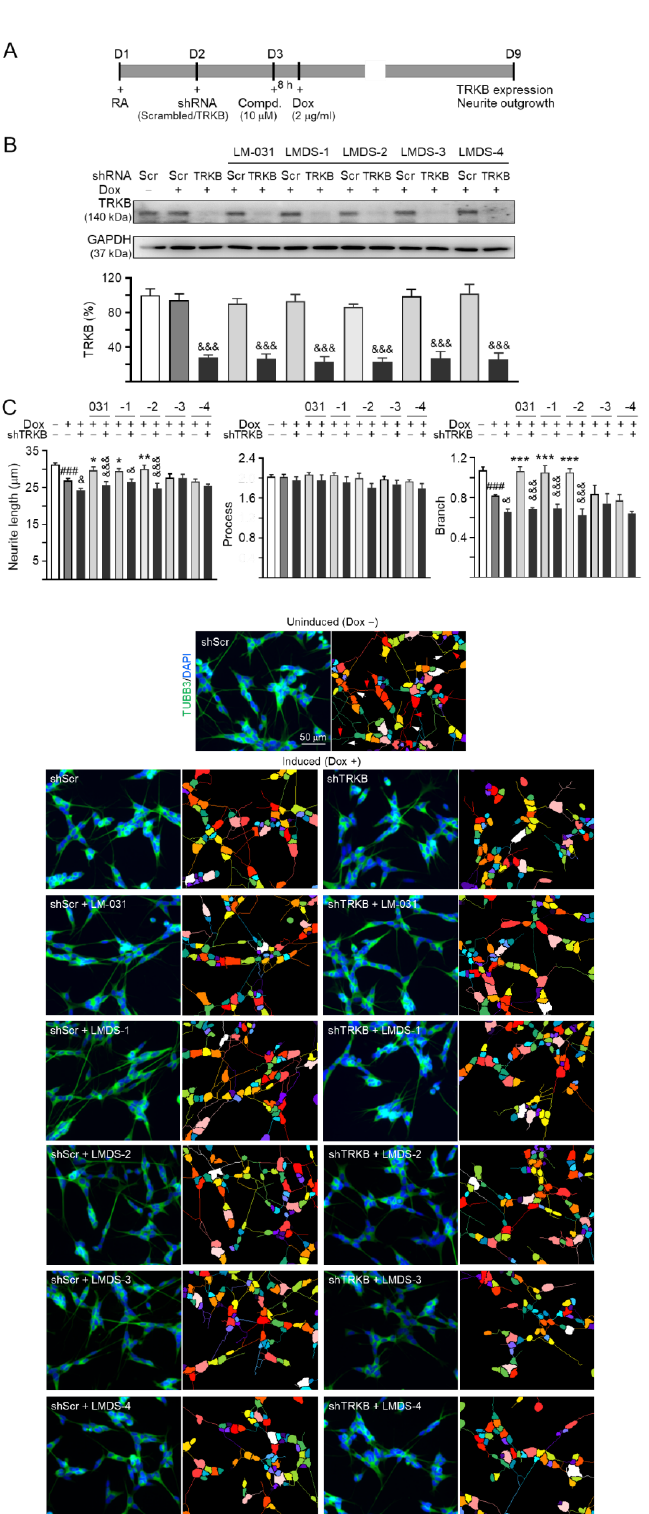
Figure 4. TRKB RNA interference of ∆ K280 tau RD -DsRed SH-SY5Y cells. ( A ) Experimental flow chart. On day 1, ΔK280 tau RD -DsRed SH-SY5Y cells were plated with retinoic acid (RA; 10 µM). On day 2, the cells were infected with lentivirus-expressing TRKB-specific or scrambled shRNA. At 24